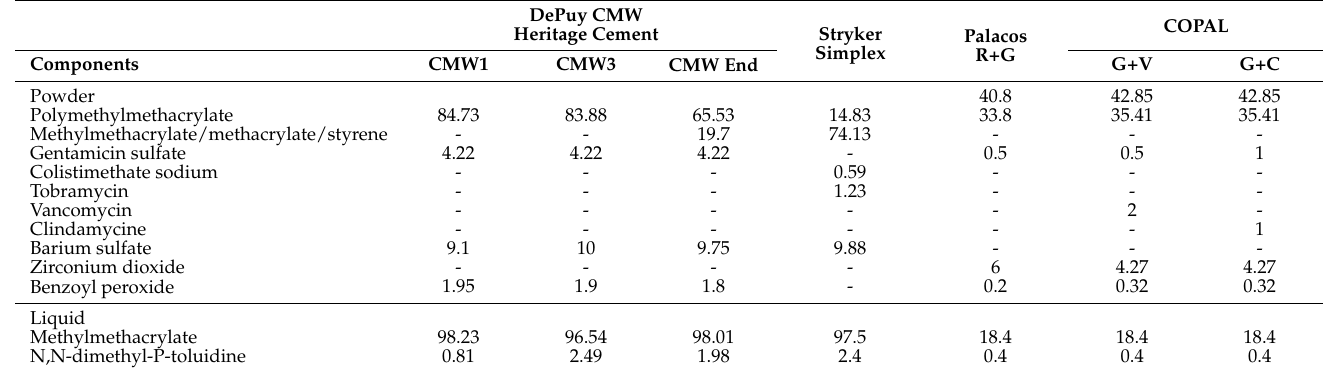
Table 1. Composition of the most common antibiotic-loaded acrylic cements used in orthopedic surgery. DePuy